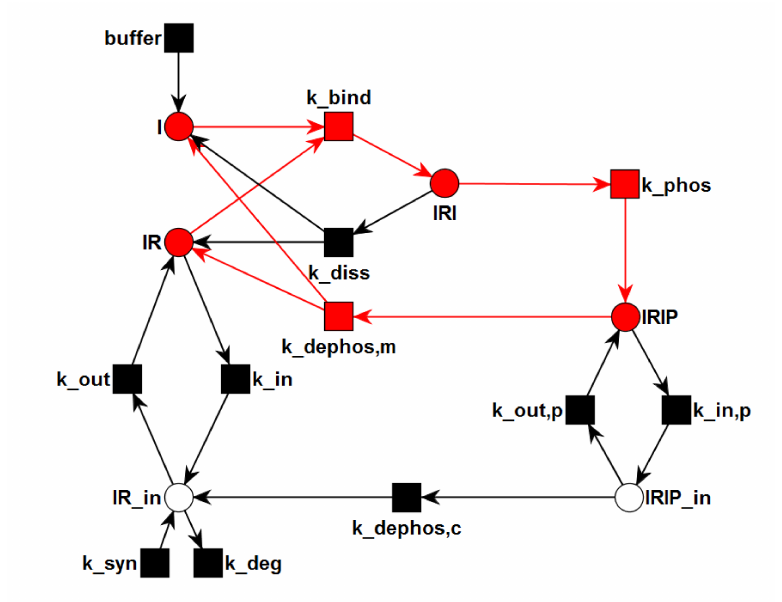
Figure 4. The transition invariant, TI of the processes: binding of insulin to the IR ( k complex ( k ), and extracellular dissociation of the activated insulin-IR complex ( k phos The steady state of this subnetwork has an equilibrium constant of i binding of insulin to the receptor.